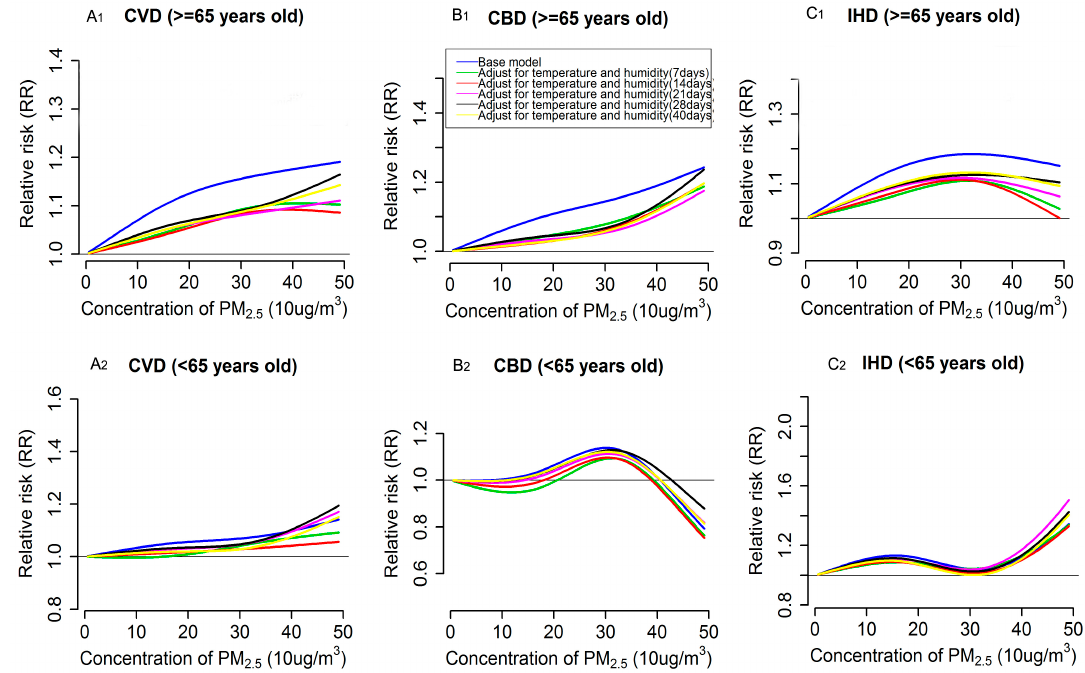
Figure 3 Exposure-response relationships for PM 2.5 (lag 0–1) with cardiovascular (CVD, A 1 , A 2 ), cerebrovascular (CBD, B 1 , B 2 ), and ischemic heart disease (IHD, C 1 , C 2 ) mortality by age group, according to single pollutant UDL models. Values are estimated relative risk of mortality associated with PM 2.5 relatives to lowest value (5.83 µ g/m 3 ). Base model(blue lines) adjusted effects of temperature and humidity only for two days(represented as two days moving average), whereas the lines with color of green, red, pink, black and yellow represent relationship from extensively adjusted models that with simultaneously adjusted cumulative effects of temperature and relative humidity for 7, 14, 21, 28 and 40 days, respectively.